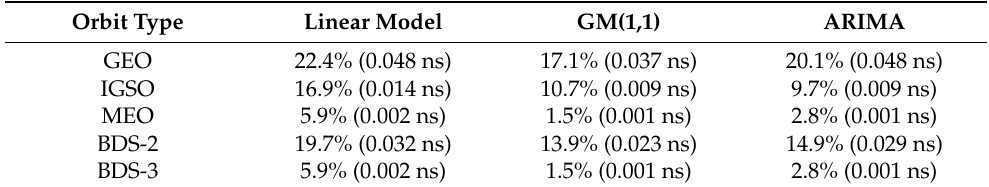
Figure 9. Frequency histogram of the clock STD improvement of the GEO, IGSO, and MEO satellites with the linear model. Table 1. Average STD improvement of the GEO, IGSO, and MEO satellites with the three